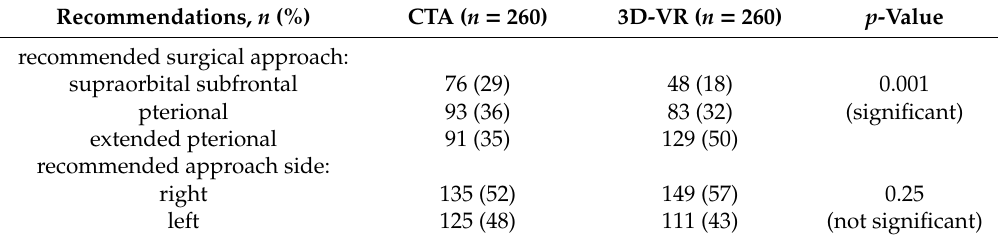
Table 5. Recommended surgical approach and approach side * after presenting conventional CTA images (2D and screen 3D) or reconstructed 3D-VR images, evaluated using Fisher’s exact test, assuming a p -value < 0.05 to be